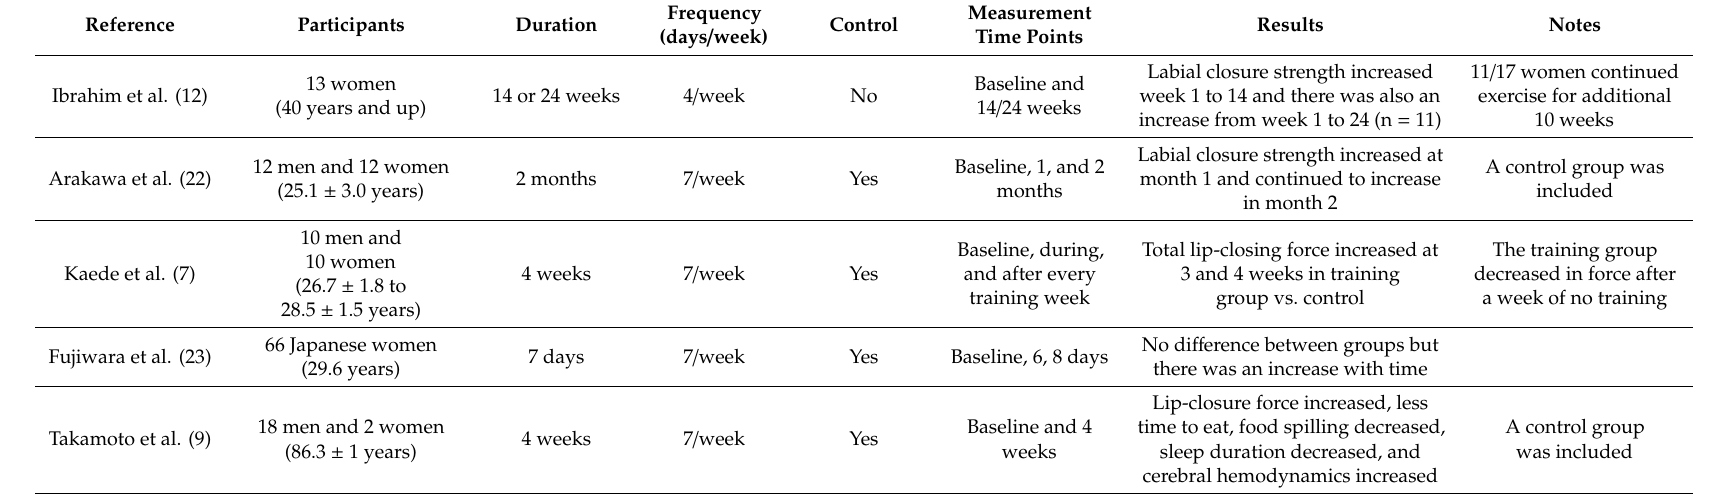
Table 1. Lip strength training in healthy